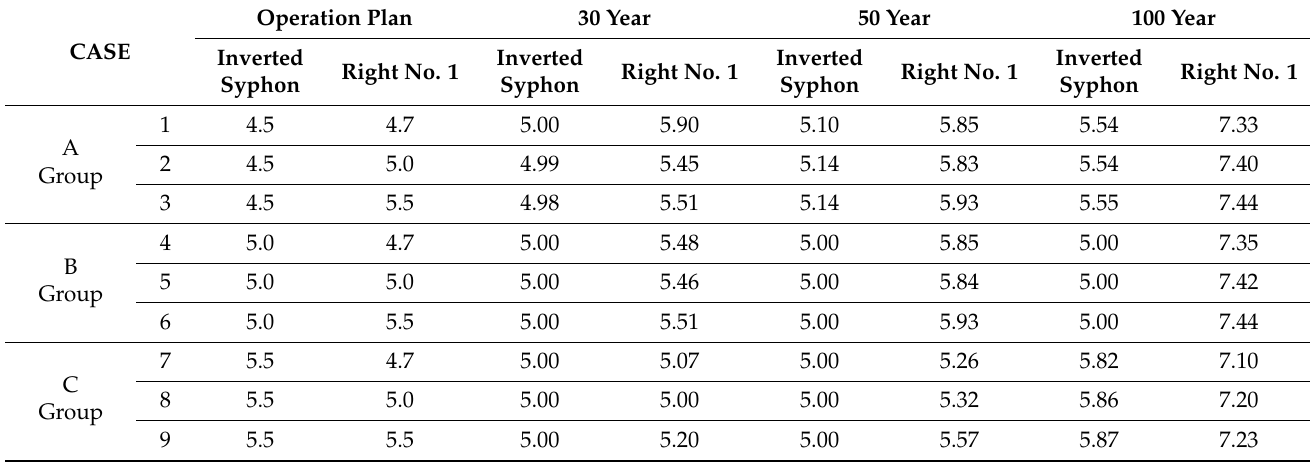
Table 6. Summary of Water Level for 30-, 50-, and 100-Year Frequency